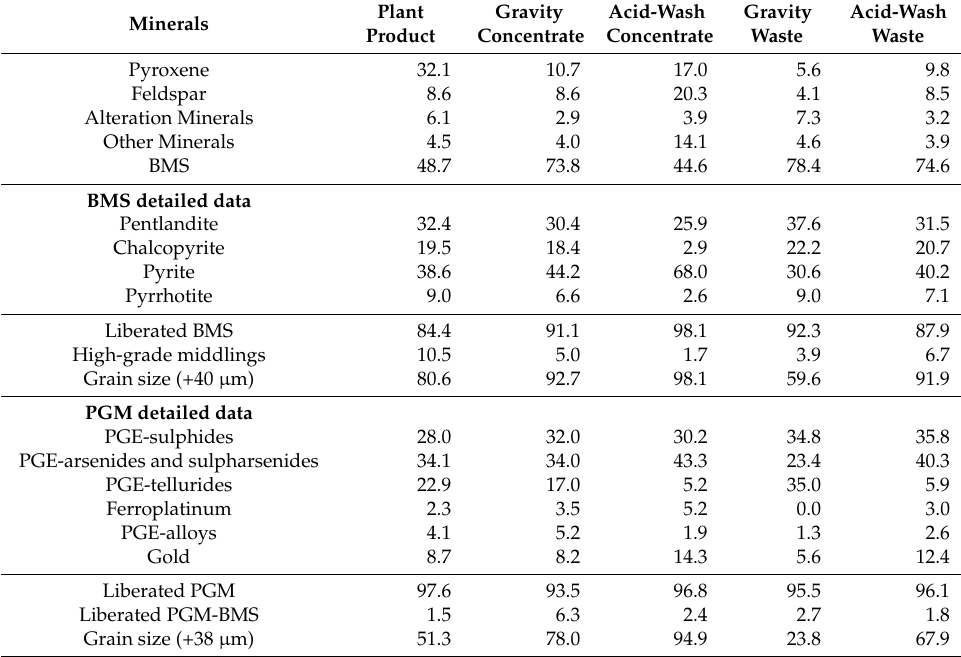
* The Bushveld ores contain a variety of platinum-group minerals. For simplification, these are commonly grouped into different classes such as alloys or intermetallic compounds, or they are based on the ligands the platinum group elements are bonded to, i.e., PGE-sulphides such as braggite ((Pt,Pd)S), cooperite (PtS), etc.; ** liberated PGM-BMS: particles consisting of platinum-group minerals and base-metal sulphides. PGM may be fully included in the sulphide grain or occur as grains attached to the sulphide. The combination of PGM and sulphide is recoverable by flotation as well as gravity separation. Table 5. Mineralogical data of the Platreef plant product (high sulphide content). All values in per cent as determined by QEMSCAN (gangue mineral and sulphide data) and MLA (PGM